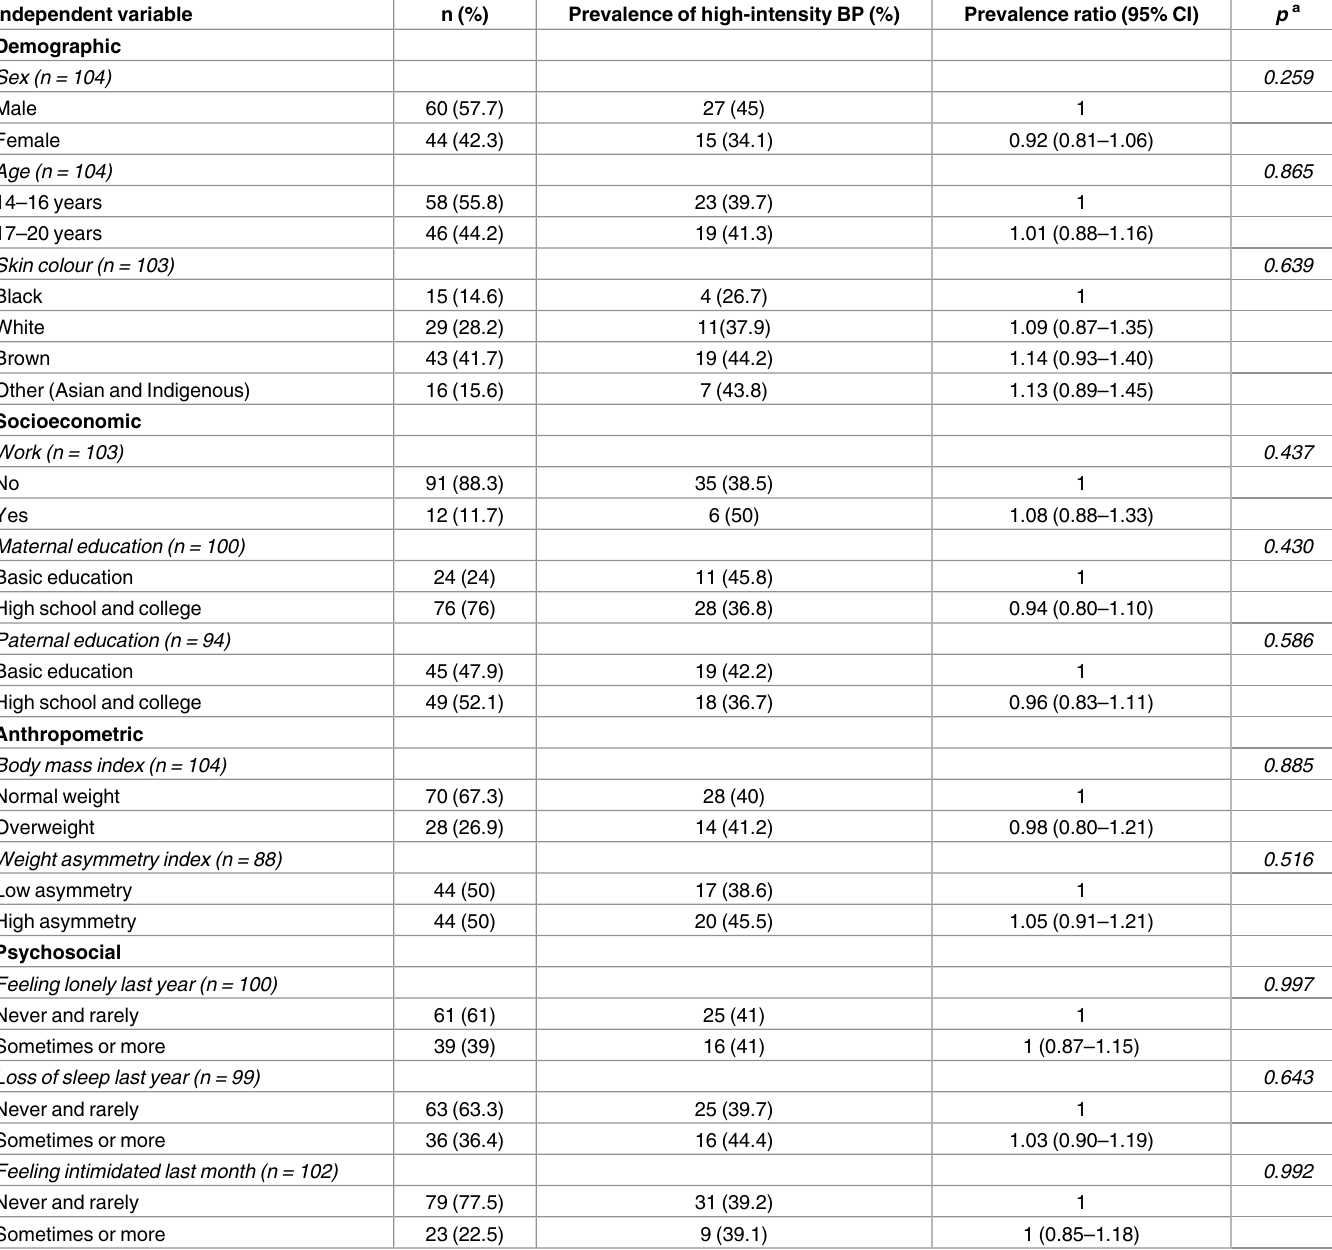
Table 2. Association ( χ 2 ) and prevalence ratio of back pain intensity with independent variables (demographic, socioeconomic, anthropometric, and psychosocial). Independent variable n